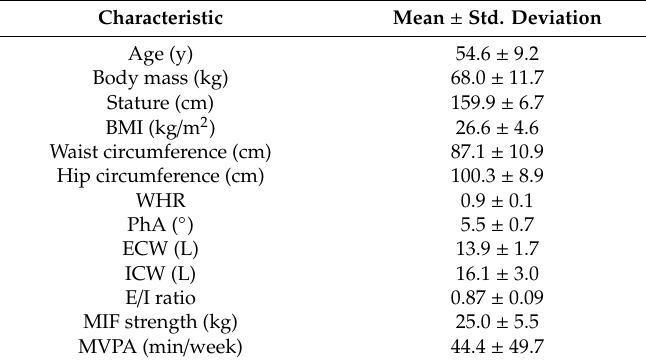
Table 1. Participant characteristics ( N = 41).